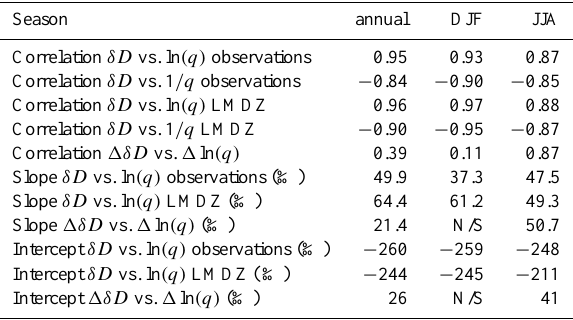
Table 8. Relationships between δD and q and between 1δD and 1 ln (q) . The 1 sign refers to the model–data difference. N/S means “not